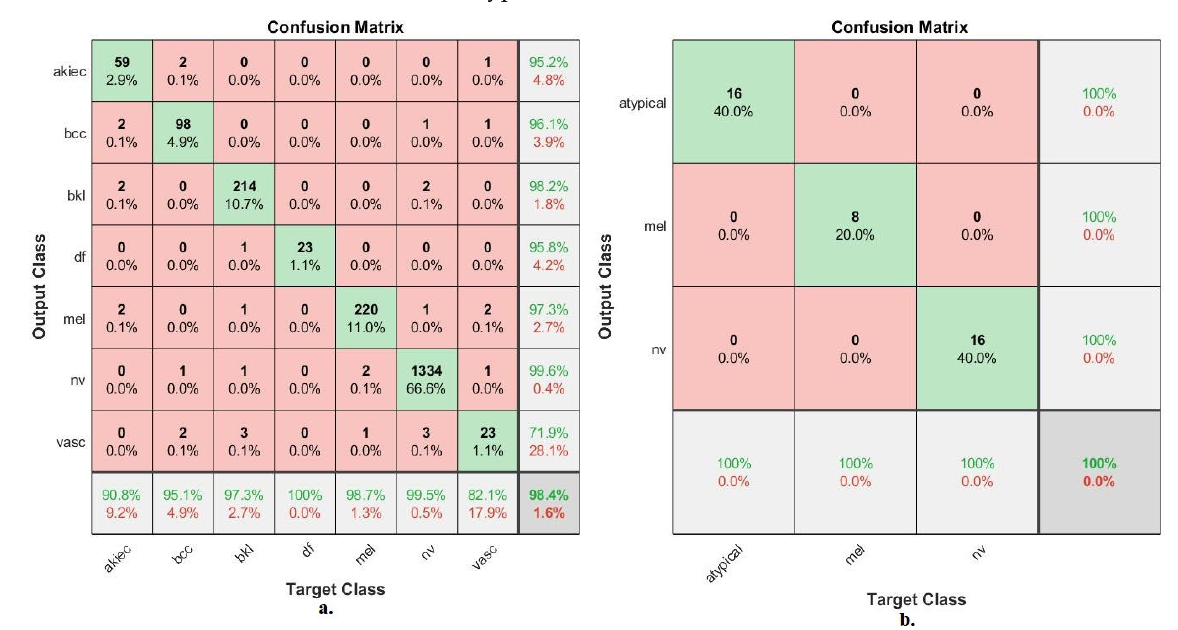
Figure 14. Confusion matrix for the classification of two skin lesion datasets by ANN with fused features of MobileNet and handcrafted through datasets of ( a ) HAM10000 and ( b ) PH2. The ANN with hybrid features of ResNet101 and handcrafted produced the confusion matrix as shown in Figure 15 for the HAM10000 and PH2 datasets. First, for the HAM10000 dataset, ANN gave an accuracy for each class as follows: 89.2% for akiec class,